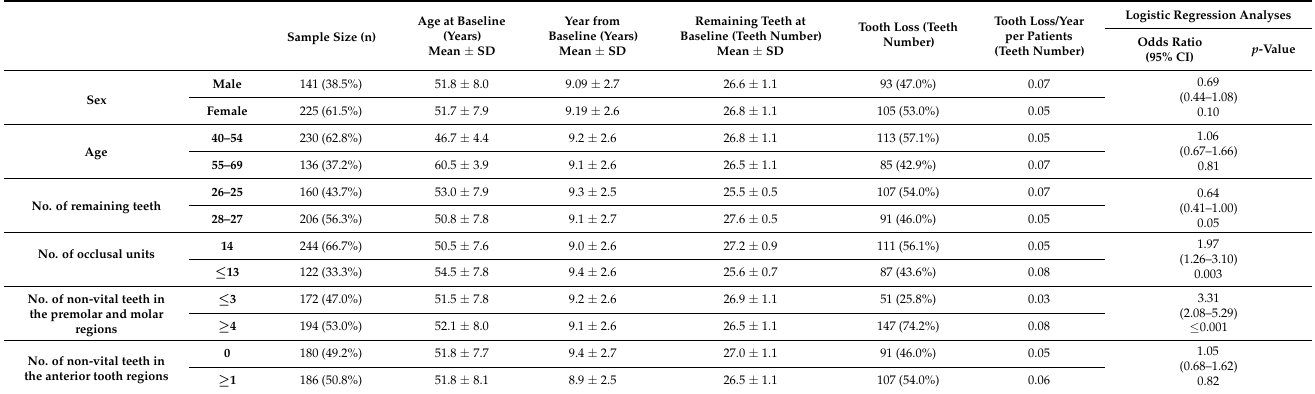
Table 6. Relationships of study variables with tooth loss.